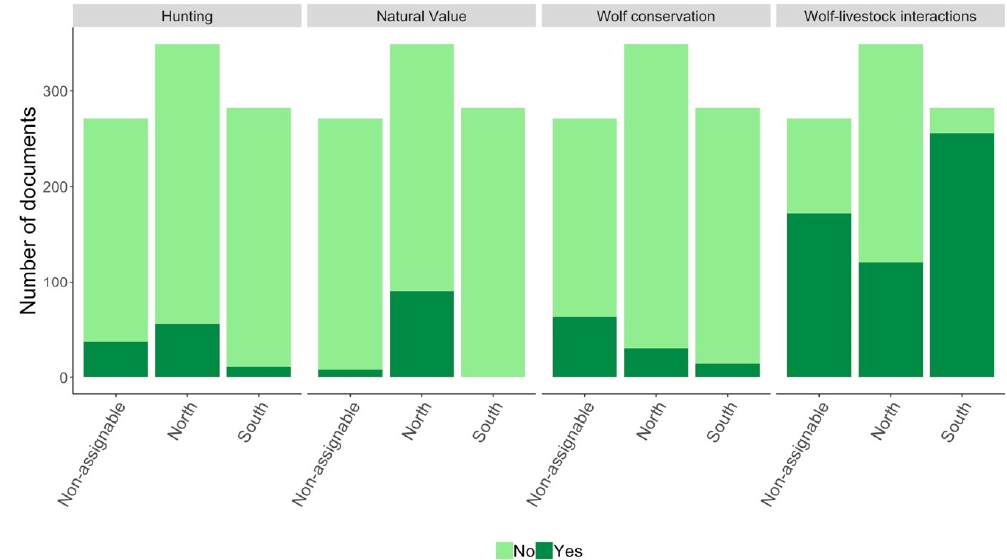
Figure 3. Number of documents published on the four main topics identified based on the three categories of areas considered: north of the River Douro, south of the River Douro, and non-assignable (i.e., larger spatial scales or generic documents).